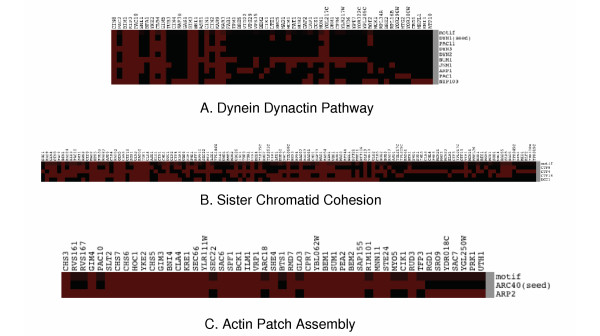
Representative genetic interaction patterns of the seed, the motif and motif members. Seed genes for the motifs are (a) DYN1 (b) CTF8 (c) ARC40. The columns correspond to library genes (interaction partners of query genes). Library genes that have no interaction with the seed and the motif members are not shown. Synthetic lethal interactions are represented by red squares. The non-binary values of the motifs are shown by intermediate colors changing from black to red.